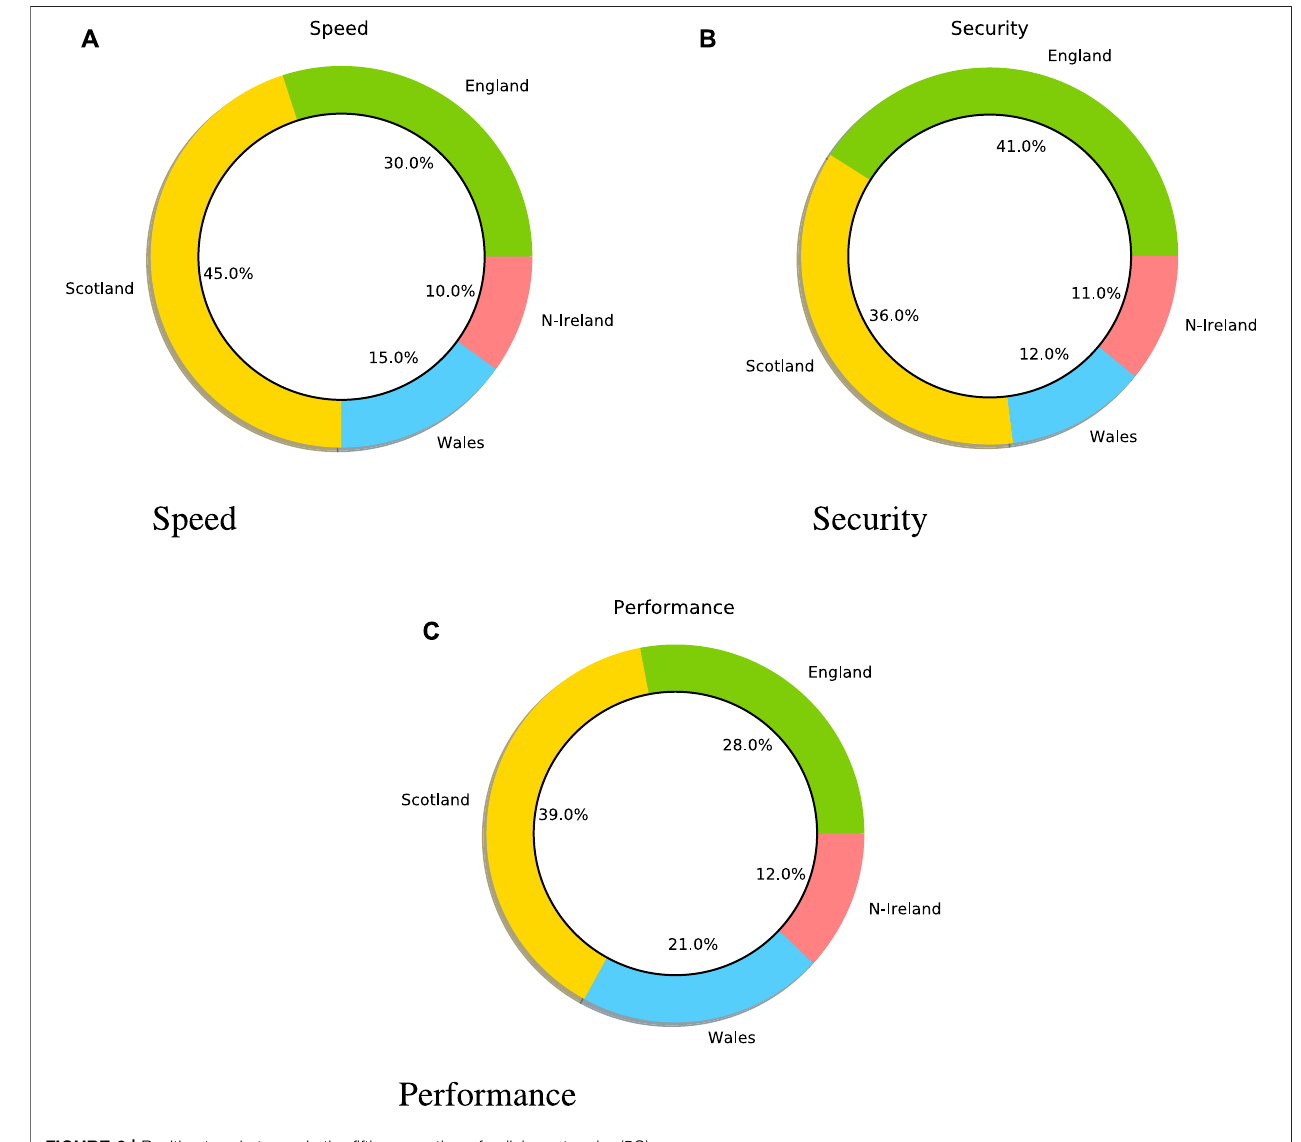
Frontiers in Big Data |